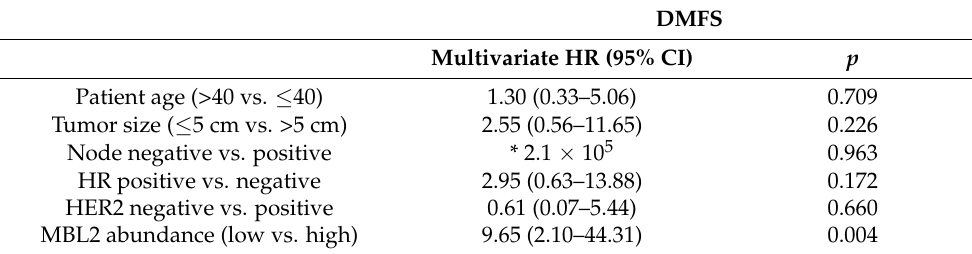
Figure 4. Kaplan–Meier plots of pathological complete response (pCR) and three proteins, MBL2, ENG, and P4HB. ( A ) Categorization of patients into pCR and non—pCR risk groups (pCR, n = 15, 6.7%; non-pCR, n = 36, 38.9%; p = 2.59 × 10 −2 ). Classification of patients into risk groups according to ( B ) MBL2 abundance: low abundance group ( n = 34, 17.6%) and high abundance group ( n = 17, 52.9%), p = 4.21 × 10 −3 ; ( C ) ENG abundance: low abundance group ( n = 12, 8.3%) and high abundance group ( n = 39, 35.9%), p = 7.34 × 10 −2 ; and ( D ) P4HB abundance: low abundance group ( n = 36, 6.7%) and high abundance group ( n = 15, 38.9%), p = 2.44 × 10 −2 . Statistical significance was determined using the log-rank test. p -values < 0.05 are displayed in bold. Table 3. Multivariate Cox analysis of DMFS including the MBL2 proteome.